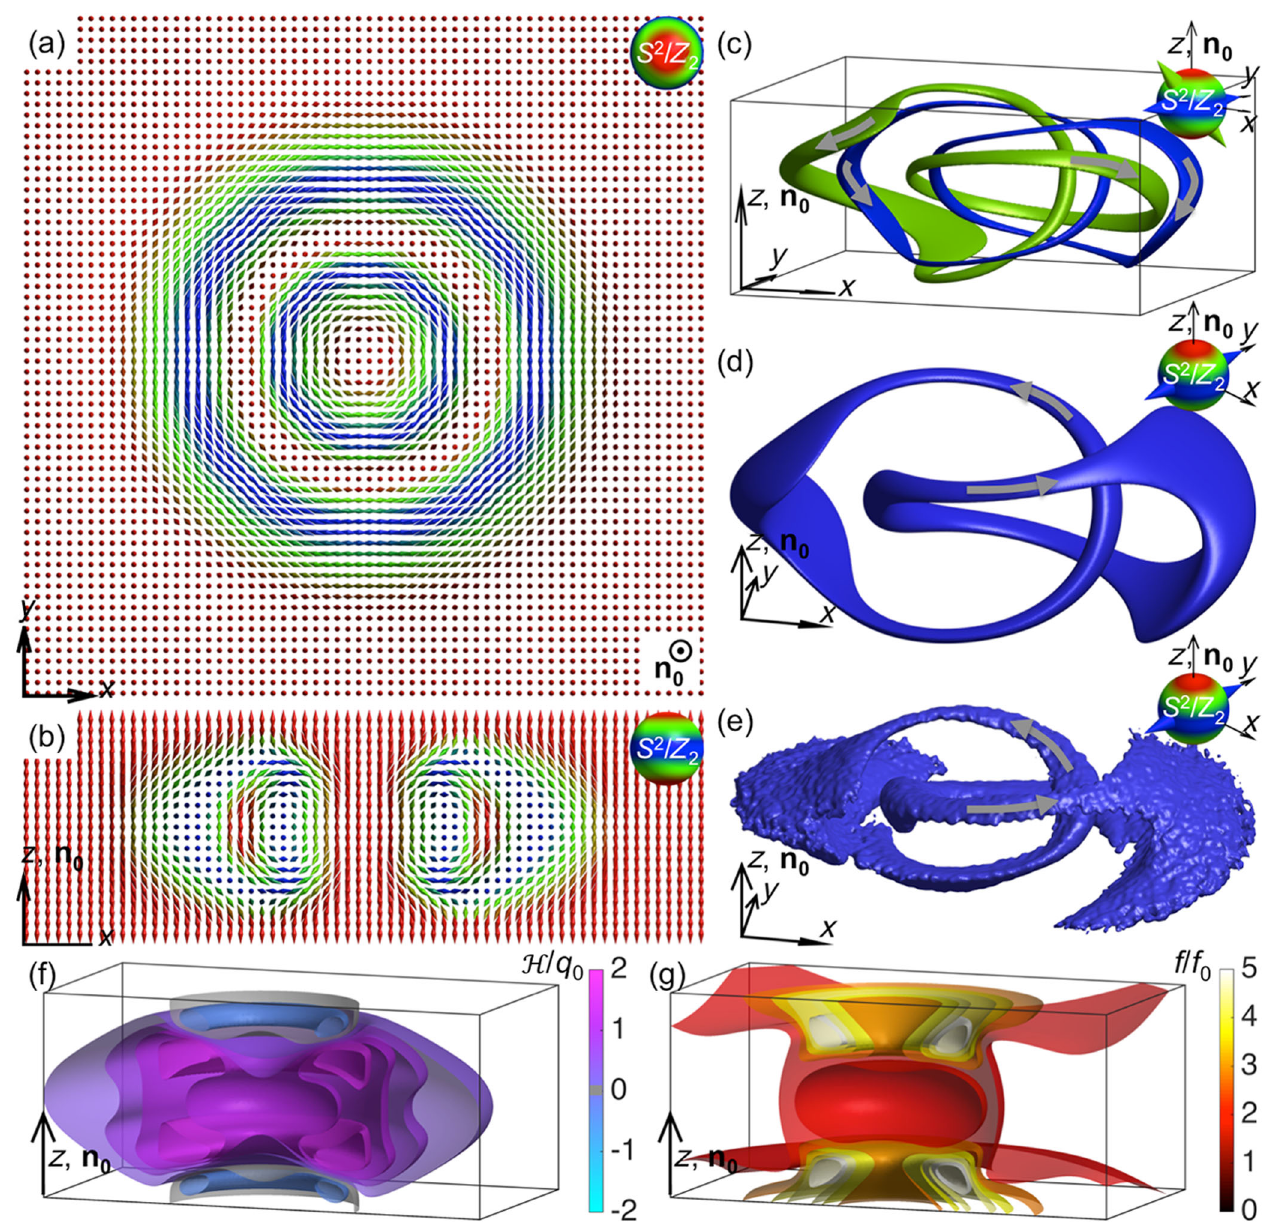
FIG. 4. 3D topological soliton with Q ¼ 1 . (a), (b) Computer-simulated (a) in-plane and (b) vertical cross sections of the axially symmetric n ð r Þ structure of the hopfion depicted using double cones and the color scheme that establishes correspondence between director orientations and the points on S 2 =Z 2 (top right insets). (c) Computer-simulated preimages of the hopfion for two sets of the diametrically opposite points on S 2 =Z 2 marked by double cones in the top right inset. (d), (e) Comparison of representative (d) computer-simulated and (e) experimental preimages of the hopfion for two diametrically opposite points on the “ equator ” of S 2 =Z 2 (top right insets). Computer simulations are performed for elastic constants of 5CB while also assuming K 24 ¼ 0 . The preimages are reconstructed based on 3PEF-PM images of structures in a 5CB-based partially polymerizable nematic LC mixture with a chiral additive CB-15, in a cell with d ¼ 10 μ m and d=p ∼ 1 ; before imaging, the unpolymerized 5CB is replaced by immersion oil. Linking of the two closed loops establishes the Hopf index Q ¼ 1 , as discussed in the text. Gray arrows in (c) – (e) indicate the consistently determined circulations of the preimages. (f), (g) Perspective views of the 3D computer-simulated isosurfaces of normalized (f) handedness and (g) free-energy density for this axially symmetric hopfion, with the corresponding color schemes provided in the right-hand side